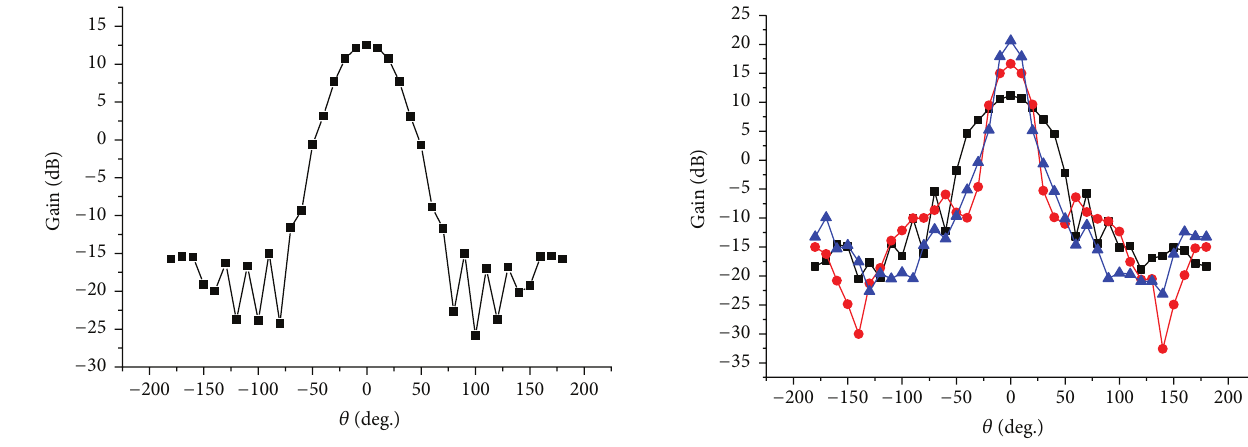
Figure 5: The gain of the antenna with 𝑓 = 1 THz and ℎ = 3𝜆 .